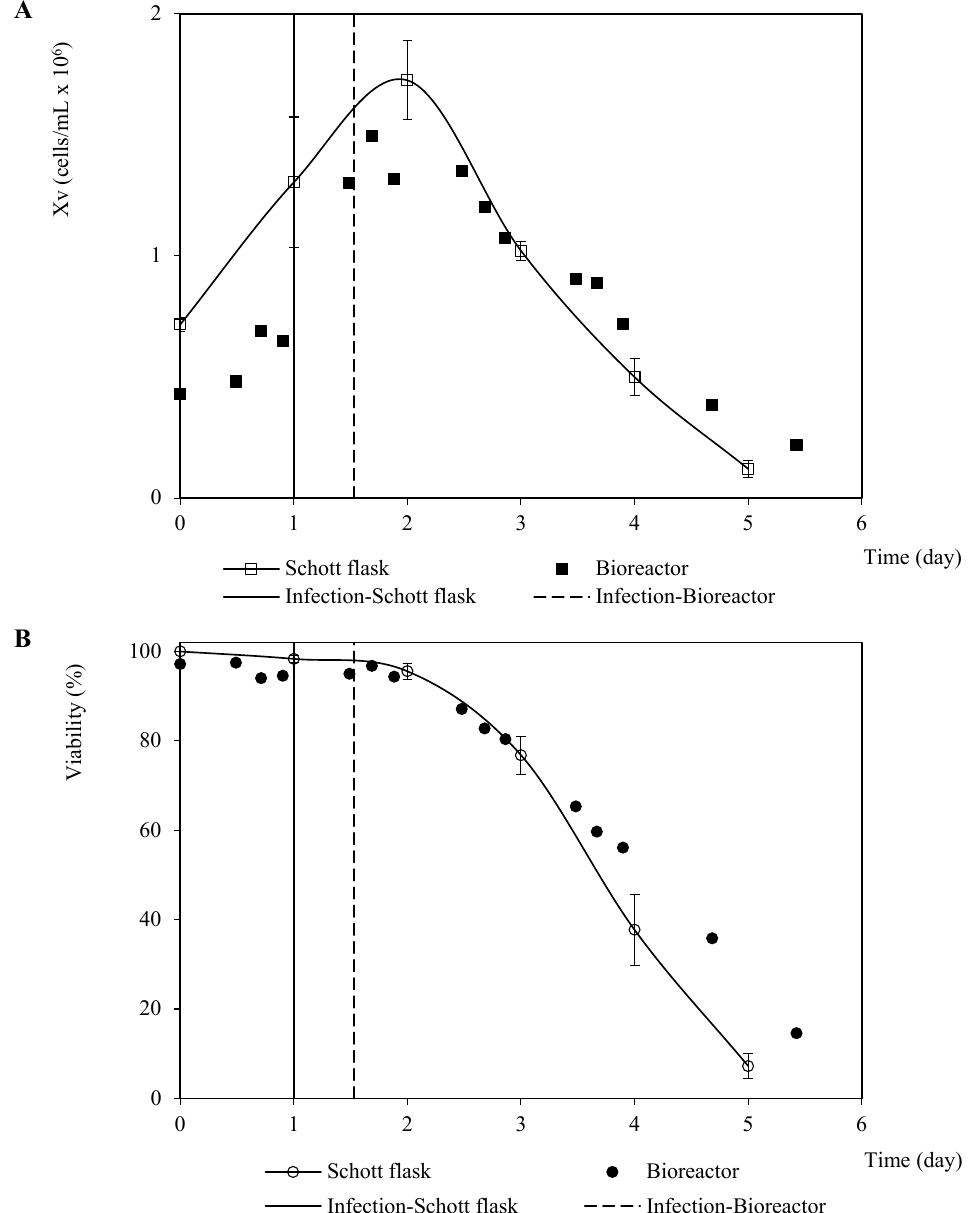
Figure 3. Patterns of viable cell density and viability corresponding to Sf9 cells infected with recombinant baculovirus carrying the rabies M protein at 0.1 pfu/cell MOI in Schott flask and bioreactor. ( A ) Viable cell density pattern. ( B ) Viability pattern. The points and error bars from Schott flask assays represent the average and the standard deviation of three repetitions, respectively.